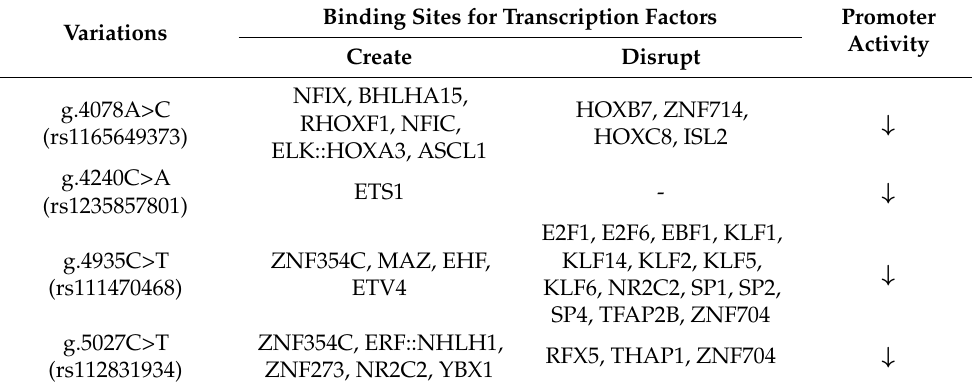
Table 3. Effects of the promoter region variants of the CITED2 gene on TFBS predicted by JASPAR